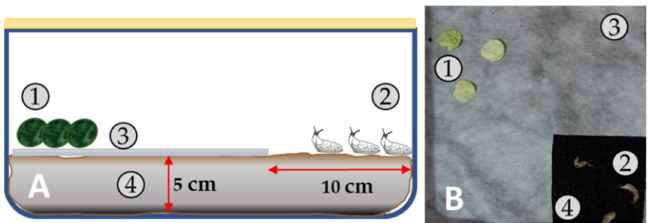
Figure 2. Experimental setup for testing an anti-slug activity of modified mats: ( A ) scheme, ( B ) top view image. Components: ( 1 ) Nappa cabbage discs ϕ 2.5 cm, ( 2 ) D. reticulatum slugs, ( 3 ) Modified non-woven mat, ( 4 ) Soil layer.